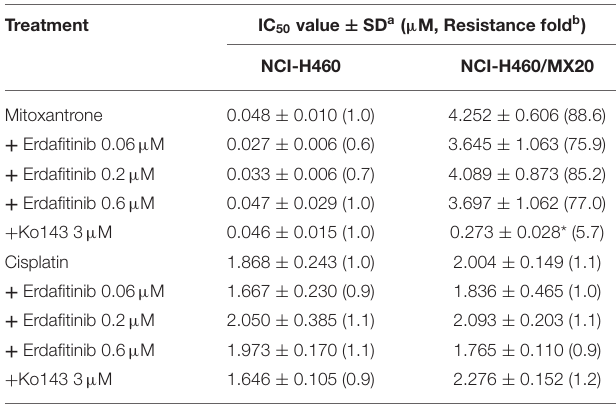
TABLE 3 | Erdafitinib did not reverse ABCG2-mediated